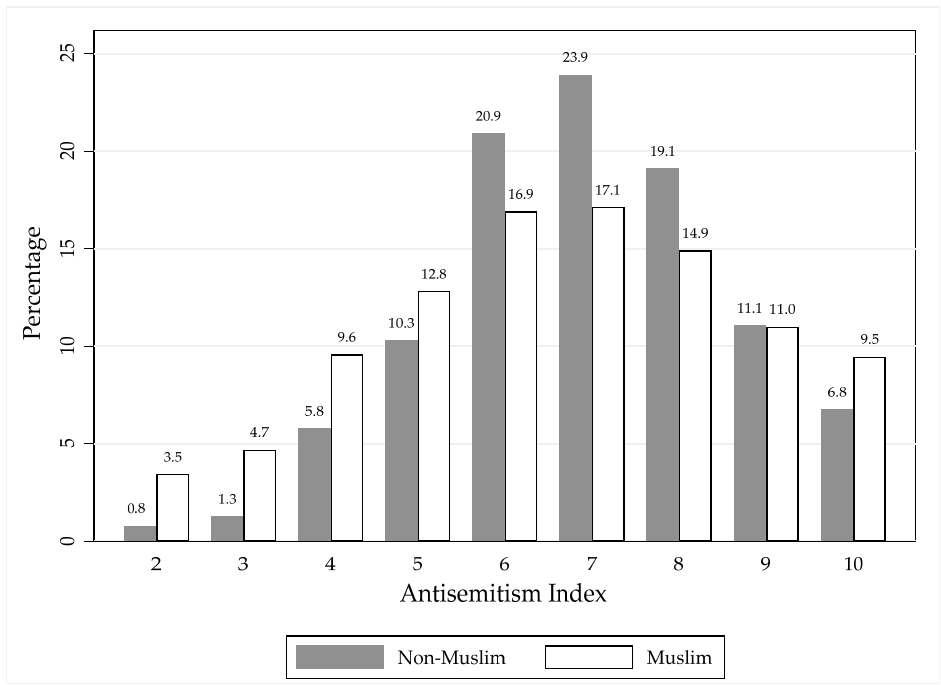
Figure 1. Antisemitism Index by Muslim vs. Non-Muslim. Source: Nationscape, as calculated by the author. See text for details.